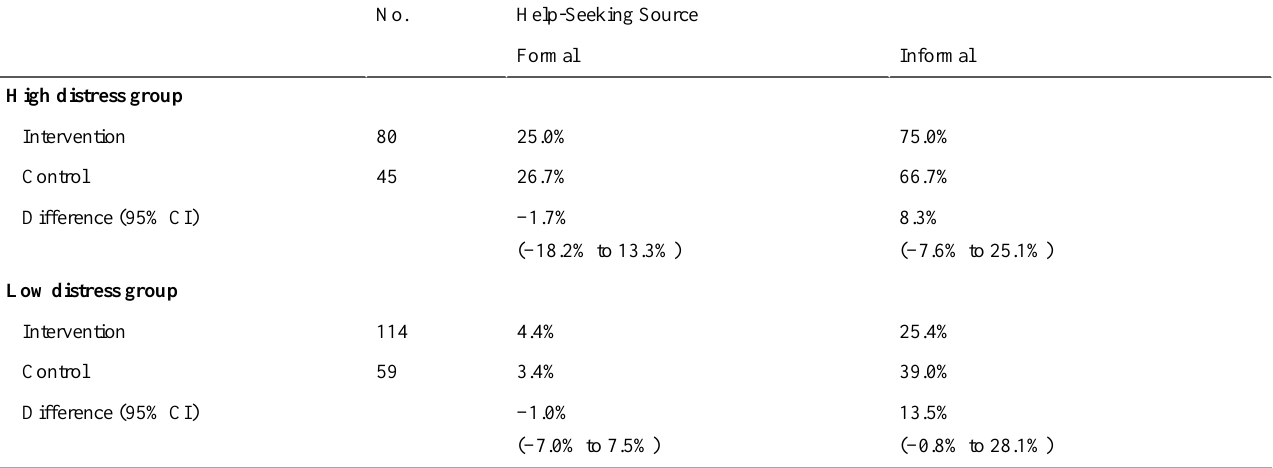
Table 2. Primary outcome: percentage of participants in each condition seeking help from formal and informal sources up to 6 weeks after the intervention